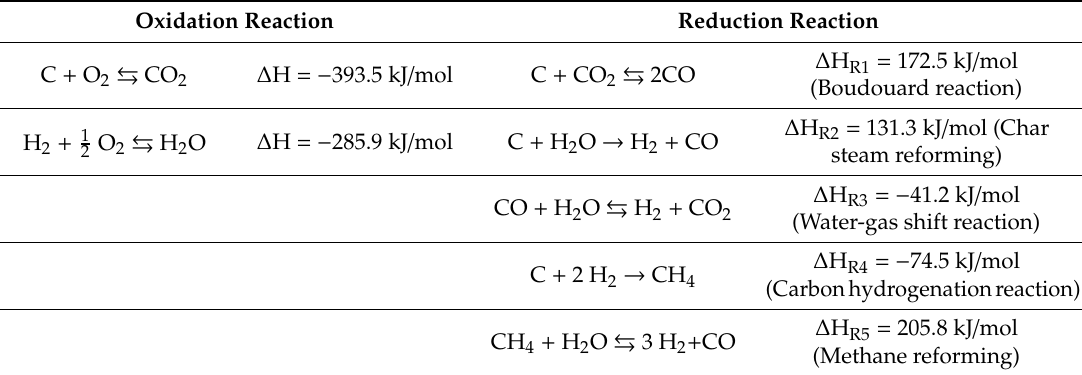
Table 2. Reactions occurring in the gasification process